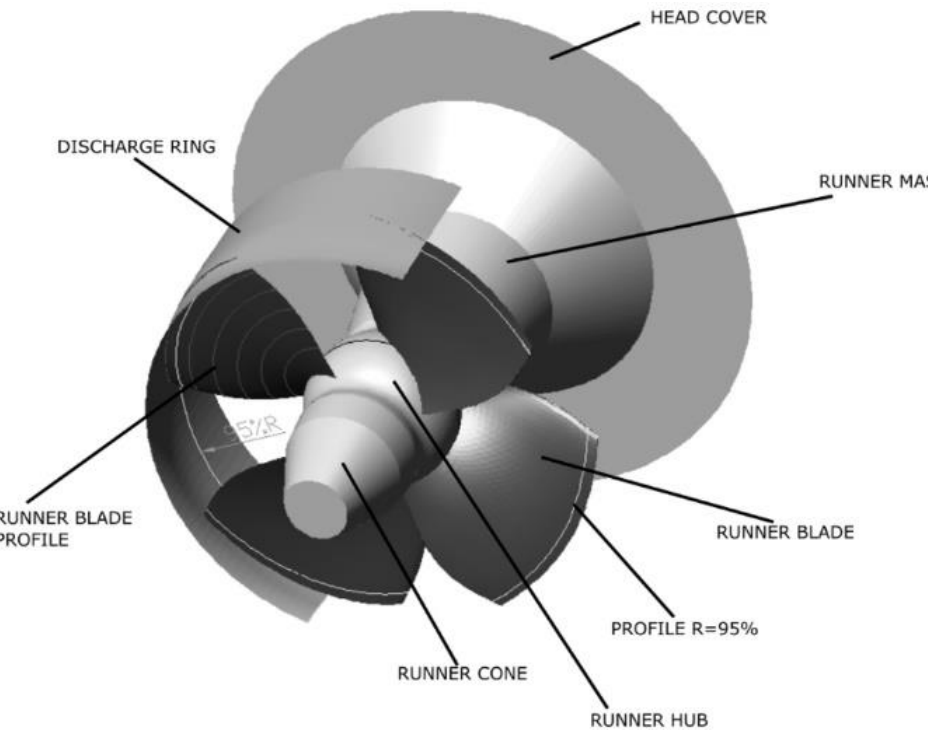
Figure 1. Bulb turbine runner.